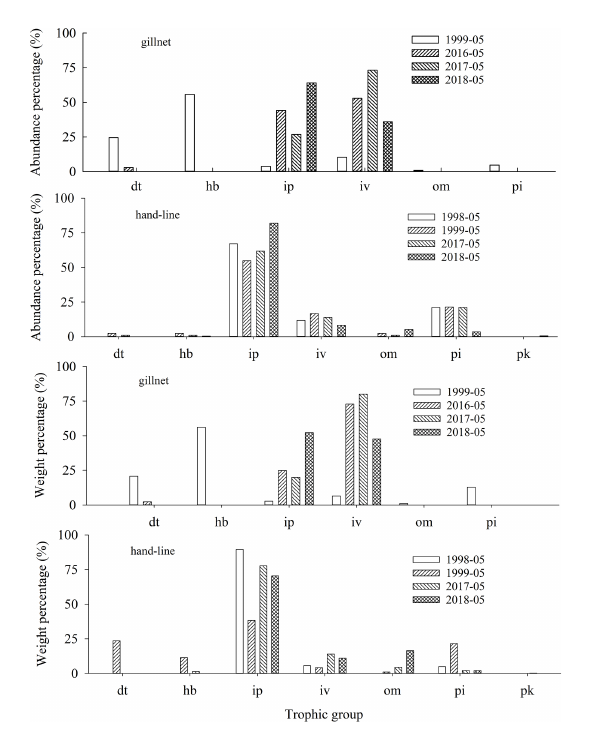
FIGURE 4 Abundance and weight percentage of different trophic fi sh in the lagoon of Meiji Reef in the South China Sea between 1998 — 1999 and 2016 — 2018. The dt, hb, ip, iv, om, pi and pk mean